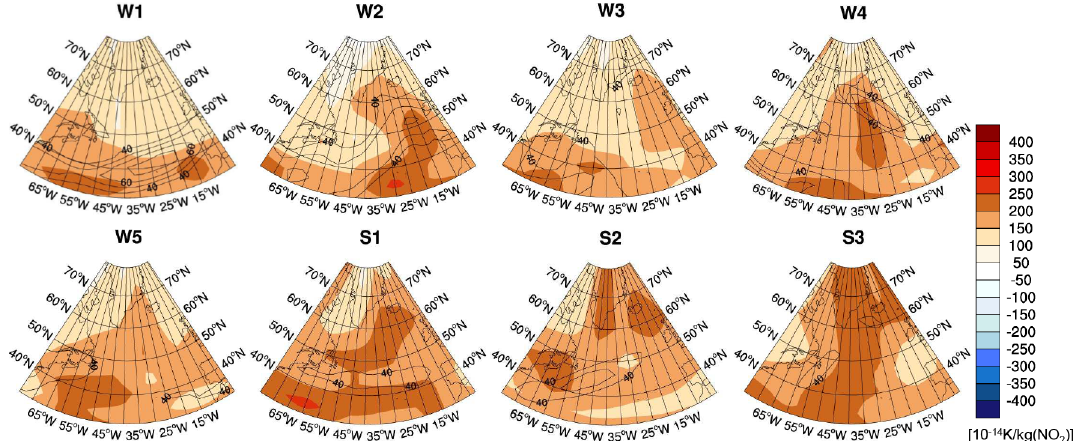
Figure 8. Climate change functions of aviation-induced O 3 at 250hPa in 10 − 14 K per kilogram of NO 2 for eight representative weather situations and an emission at 12:00UTC. The isolines show the wind speed in metres per second ( > 40ms − 1 ) at 250hPa. CCFs for other pressure levels and times investigated in this study are presented in the